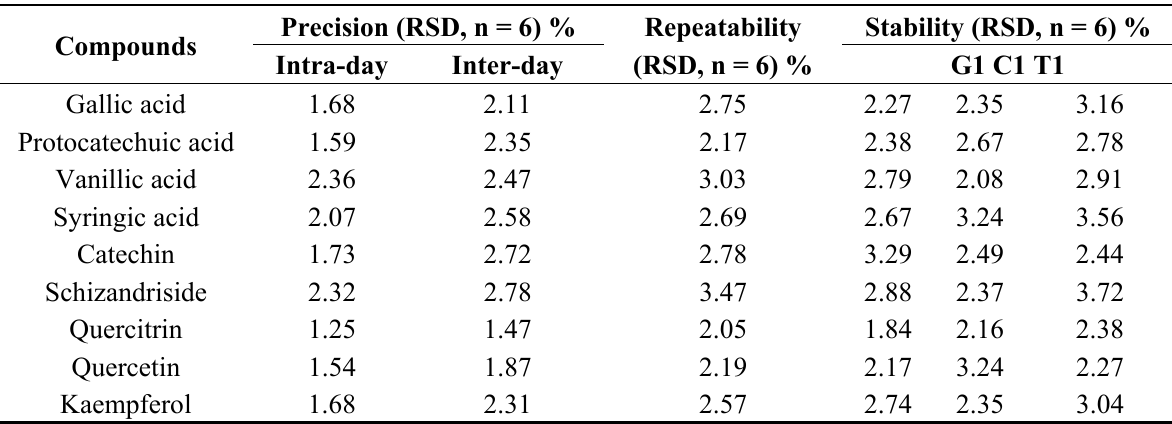
Table 3. Precision, repeatability and stability of the 9 markers. Compounds